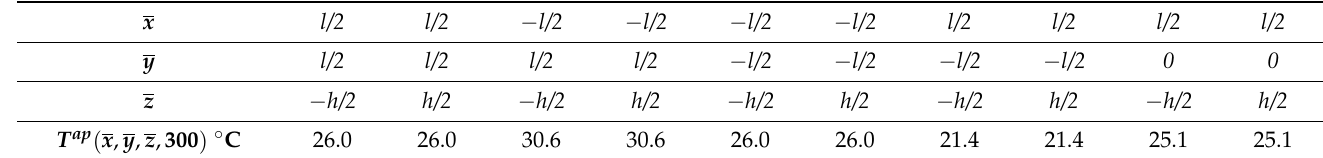
Table 5. Temperatures in the corners of the copper plate and at the midpoint of the plate’s surface facing the heated air inlet to the room for T c = 31 ◦ C, v a = 0.5 m/s, and t = 300 s.